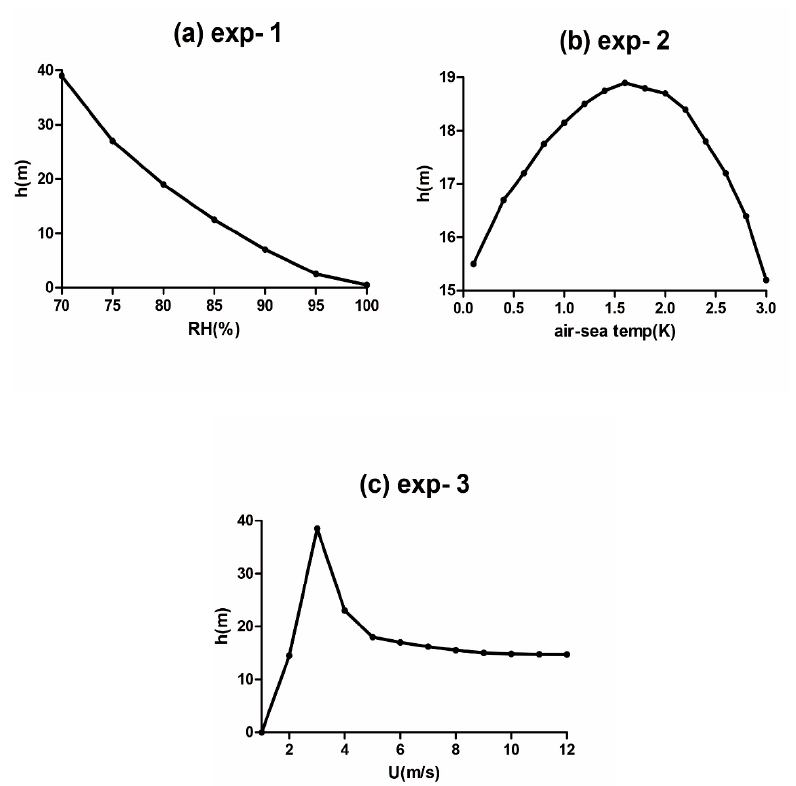
Figure 7. Influence of ( a ) air humidity, ( b ) air–sea temperature difference, and ( c ) horizontal wind speed on evaporation duct height based on the Paulus-Jeske (P-J)